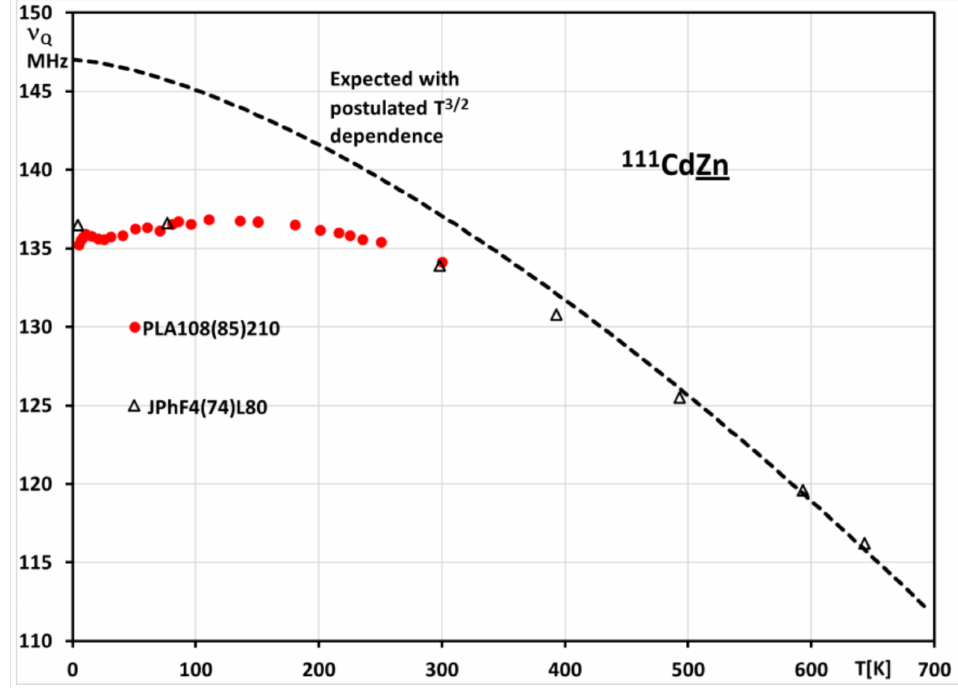
Figure 1. Existing data for ν Q for 111 Cd in Zn as a function of temperature confronted by expected dependence from T 3 / 2 “law”. References: JPhF4(74)L80 [14], PLA108(85)210